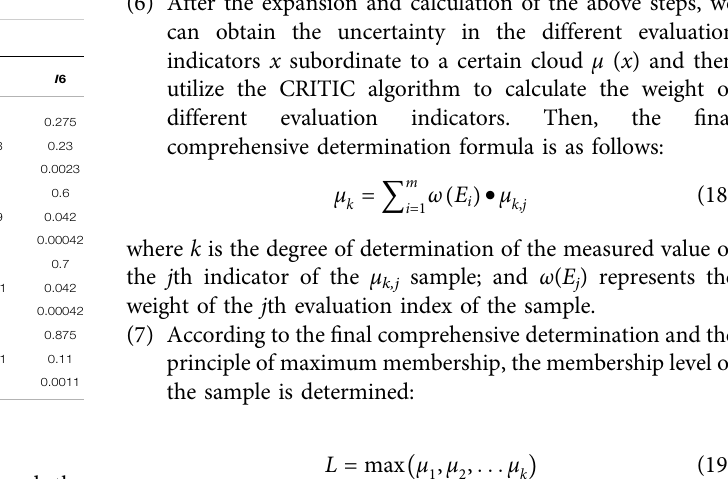
TABLE 2 | Characteristic parameters of the rock burst cloud model.